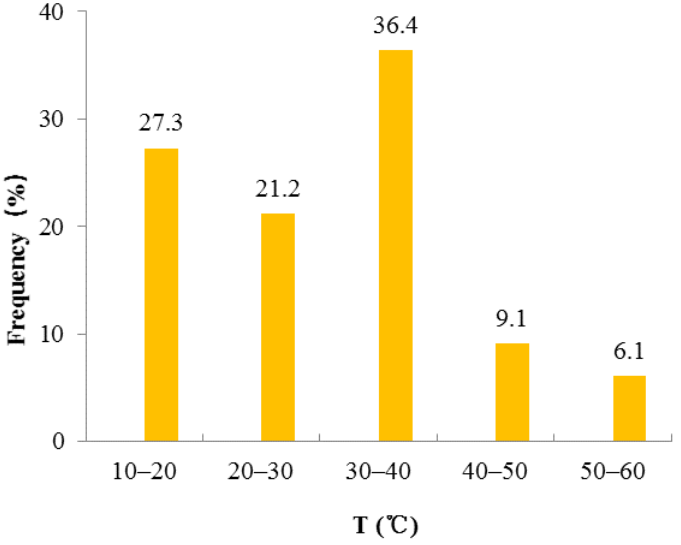
Figure 7. Distribution histogram of temperatures calculated by the calcite–water fractionation equation. calcite and